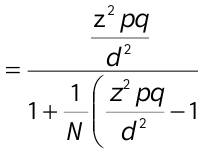
Figure 2. Environmental risk assessment of Paveh Rood Dam The population size (number of panelists in the Delphi group), in this research, was determined by Cochran’s formula as 28